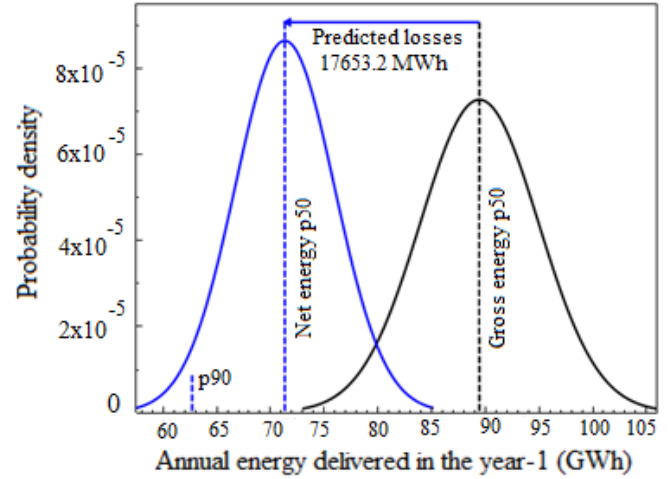
Figure 13. System’s wake losses for different distances between turbines and rows.